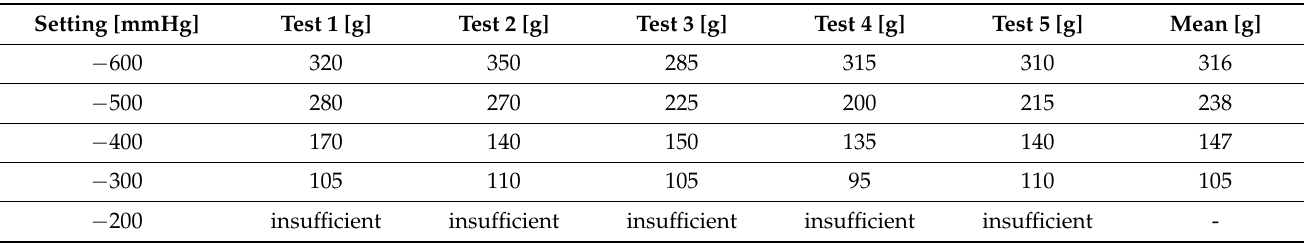
Table 1. Results of holding experiments with Medela, Basic 30”, Medela Healthcare, Switzerland (Electric